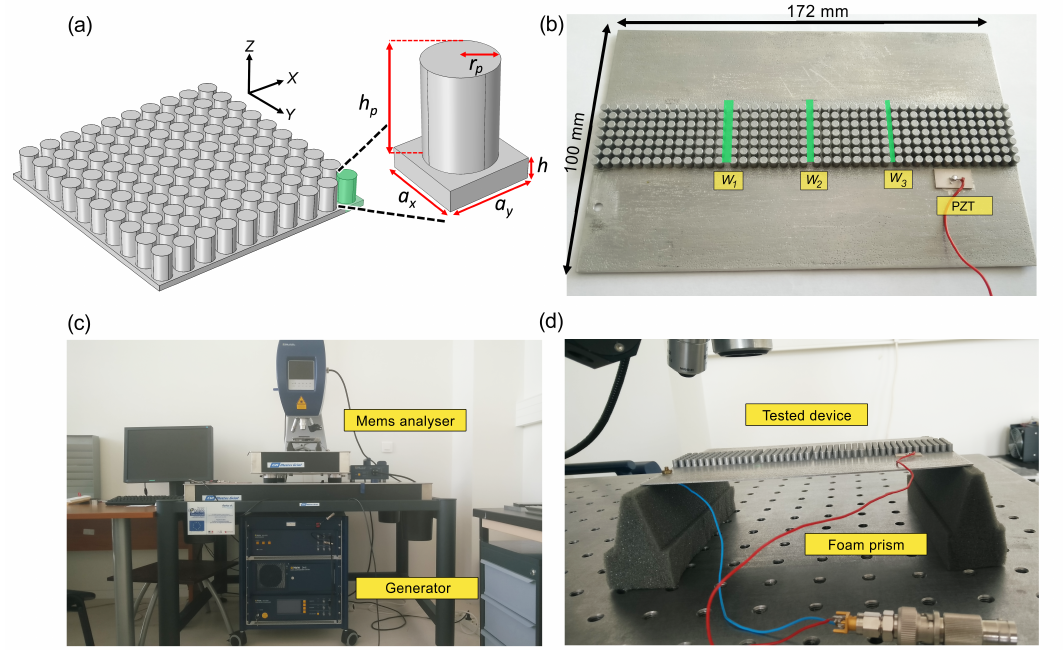
Figure 1. ( a ) unit cell configuration with height of pillar, h p = 4.4 mm, slab thickness, h = 1 mm, radius, r p = 1.6 mm, and crystal Lattice, a x = a y = 4 mm ( b ) demultiplexer device consists of 3 waveguides channels W 1 = 1.52 mm, W 2 = 1.22 mm and W 3 = 0.88 mm. Soft piezo ceramic (PZ27 by